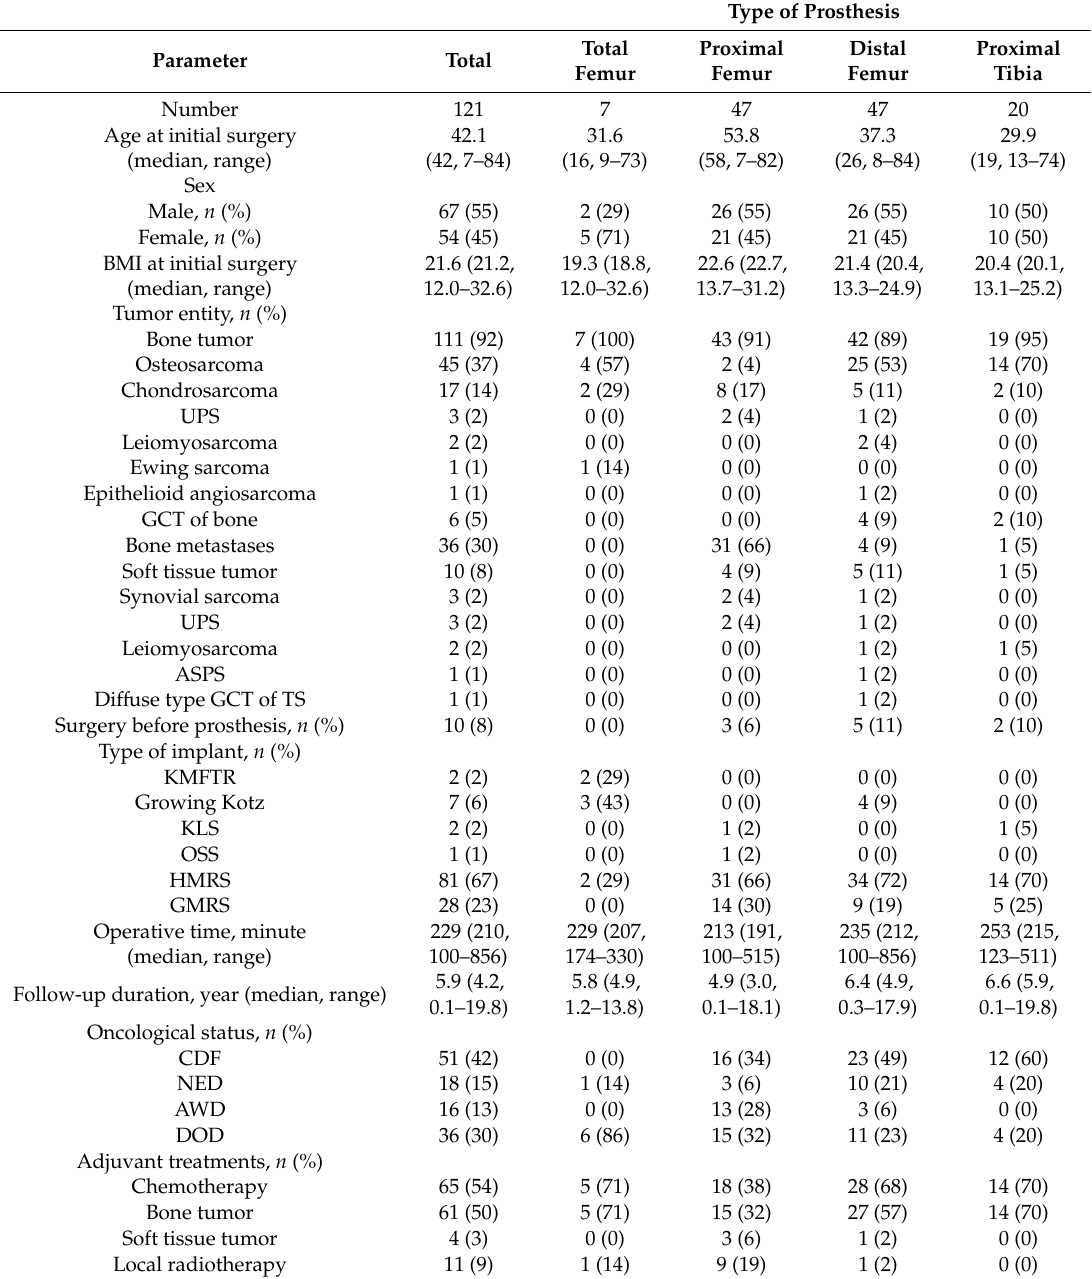
Table 1. Demographic data of 121 cases with tumor prosthesis after resection of musculoskeletal tumor of the lower